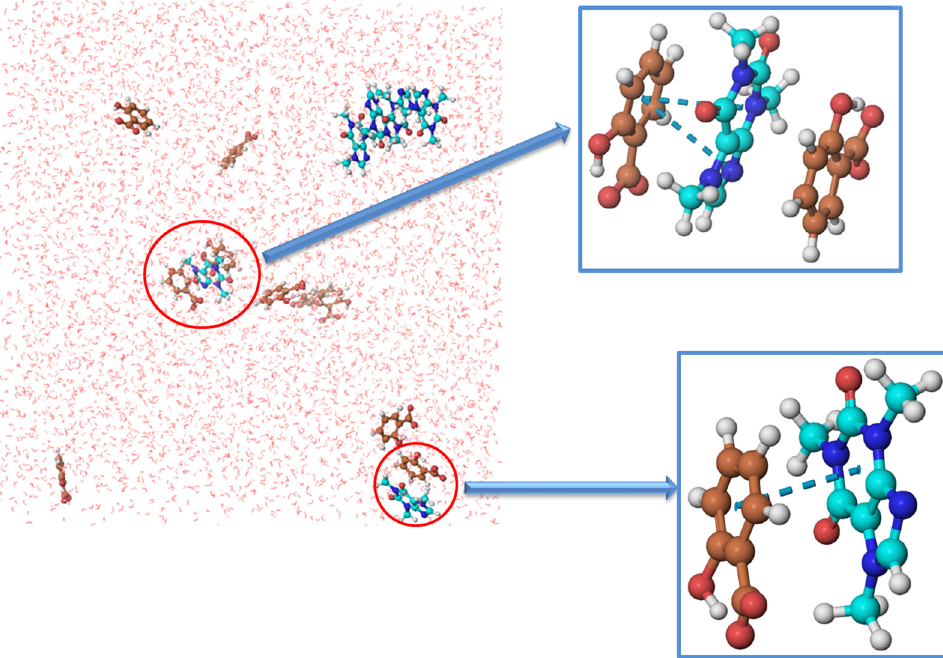
Figure 10. Visual representation obtained from the Yasara Structure program of caffeine organization in 0.1 mol ∙ kg − 1 SS aqueous solution, and blue dashed lines represent π – π interactions. The molal concentration of caffeine is 0.06 mol ∙ kg − 1 .